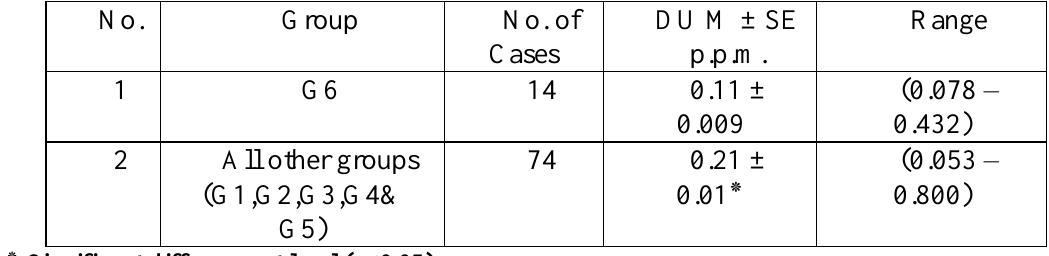
Table (1): Depleted Uranium concentrations in blood samples for all groups as compared with control group No.